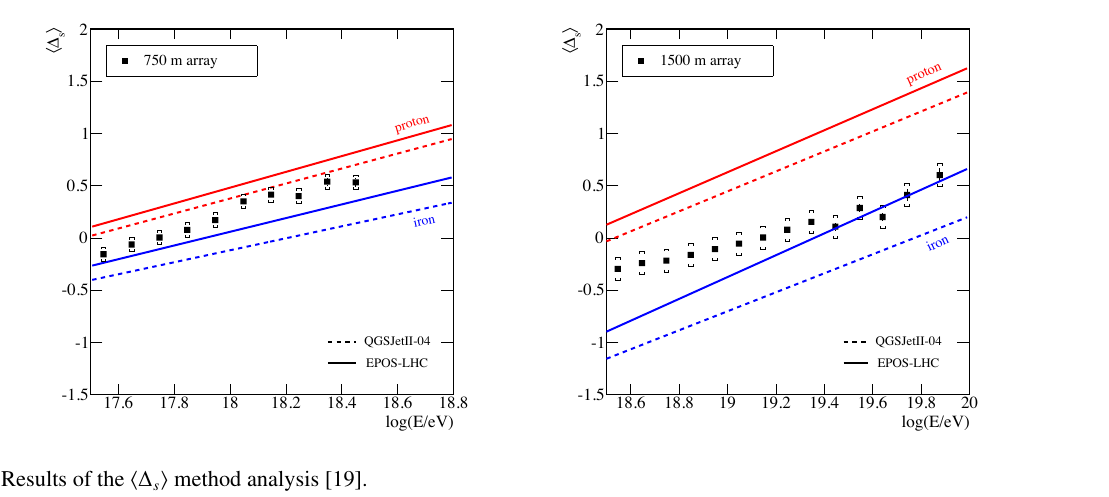
Figure 5. Results of the